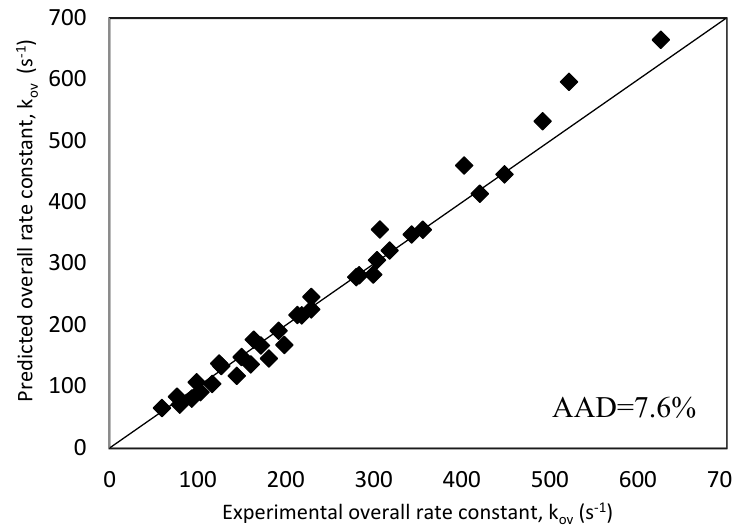
Table 5. Summarized kinetics rate constants for CO 2 -MDEA-Arg reaction using Zwitterion Mechanism.